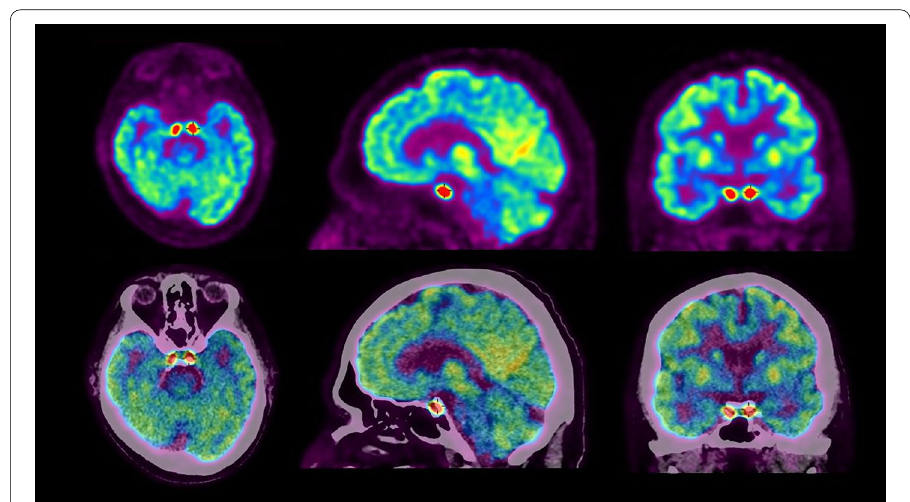
Fig. 1 Cerebral 18 F-FDG PET/CT demonstrating the presence of intense and symmetrical hypermetabolism of the cavernous